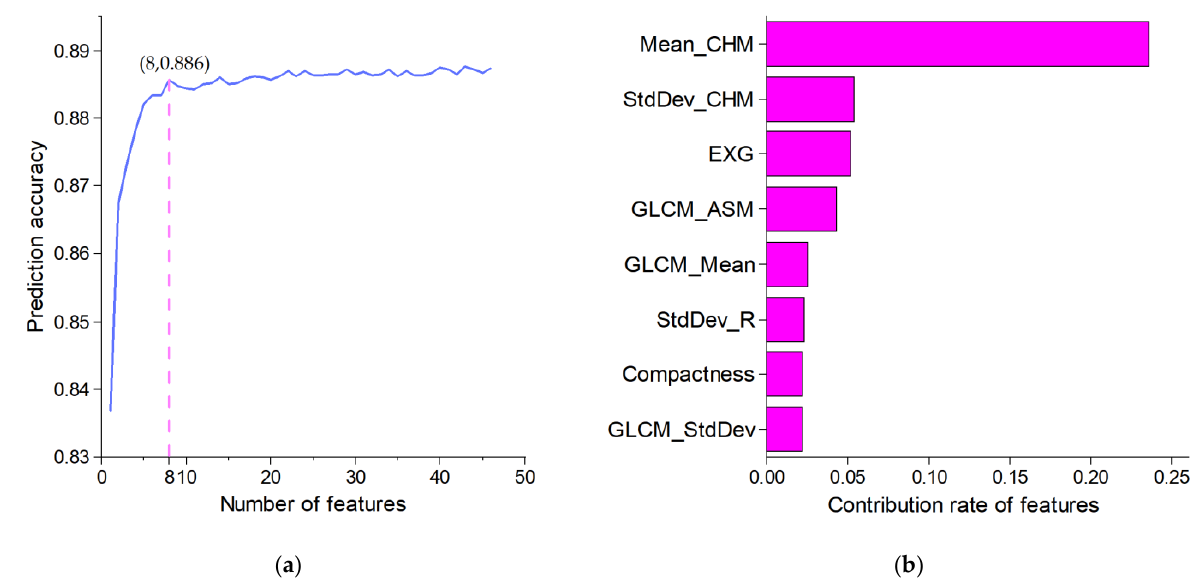
Figure 6. OOB error rates of different feature combination schemes.